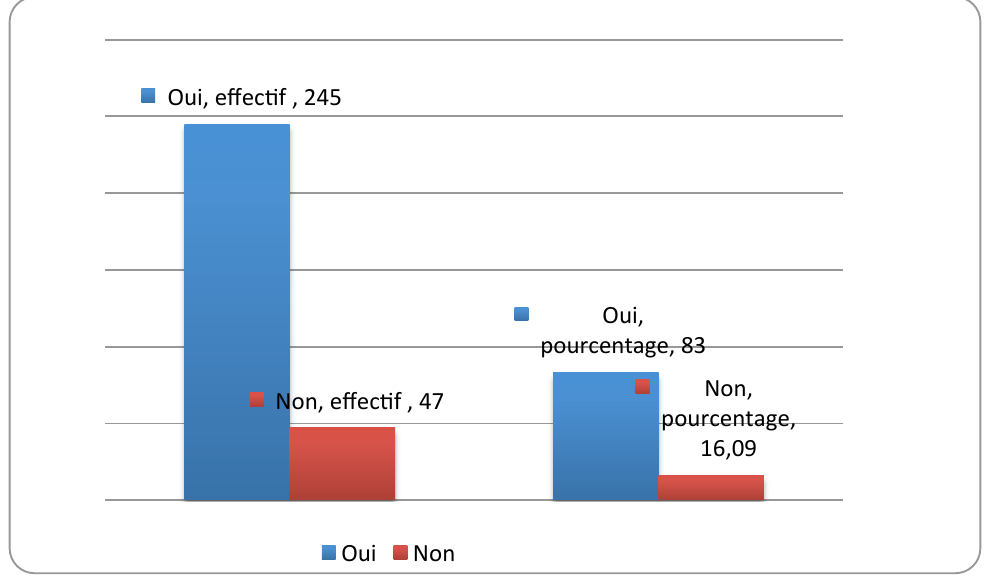
Figure 11. La santé et l’éducation des enfants des